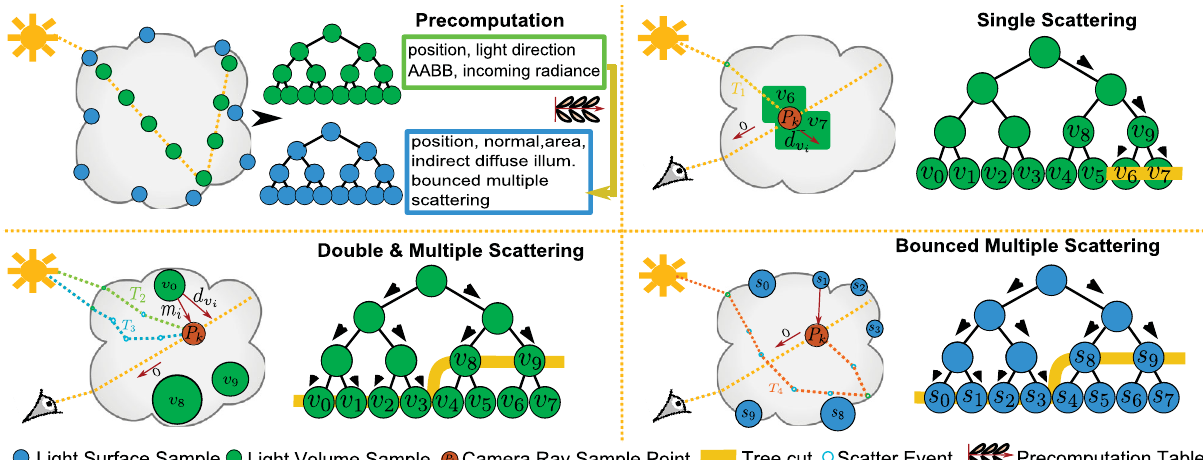
Fig. 8 PBGI framework for participating media rendering. The algorithm begins by computing incoming light for volume and surface samples. Then it computes single-, double-, and multiple-scattering effects for each camera ray using these volume and surface samples. Reproduced with permission from Ref. [4], c (cid:2) The Author(s)